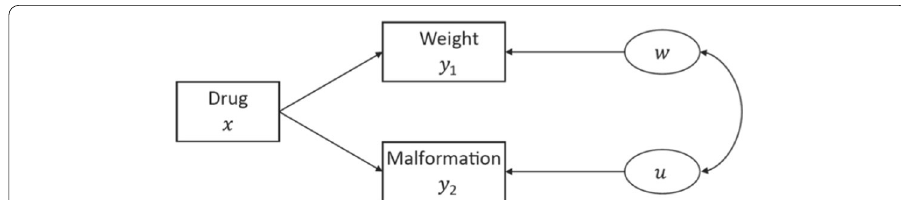
Fig. 6 Path diagram for MDHGLM towards weight and misinformation